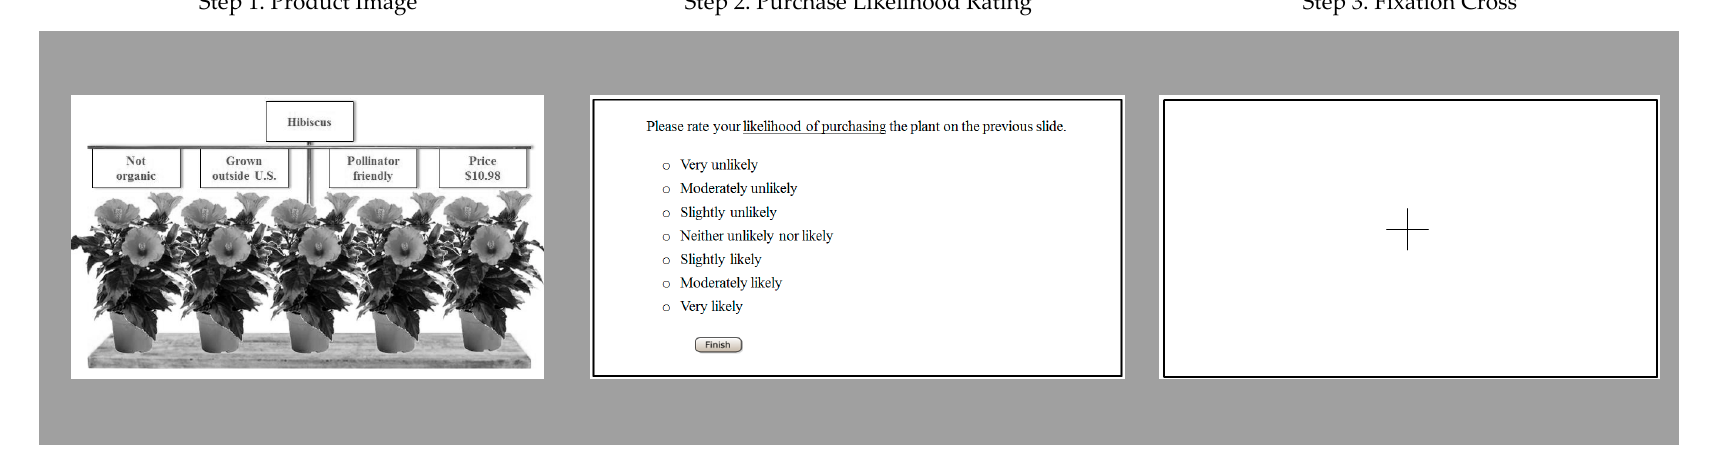
Figure 3. The three-step experimental procedure used for the 16 conjoint analysis scenarios.